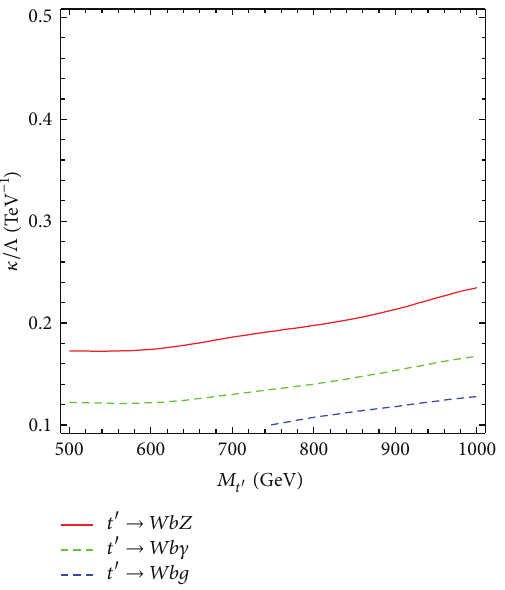
Figure 8: The contour plot of anomalous coupling and mass of new heavy quark 𝑡 󸀠 for the dynamical parametrization explained in the text with a significance of 3𝜎 at √𝑠 = 13 TeV and 𝐿 int = 100 fb −1 .